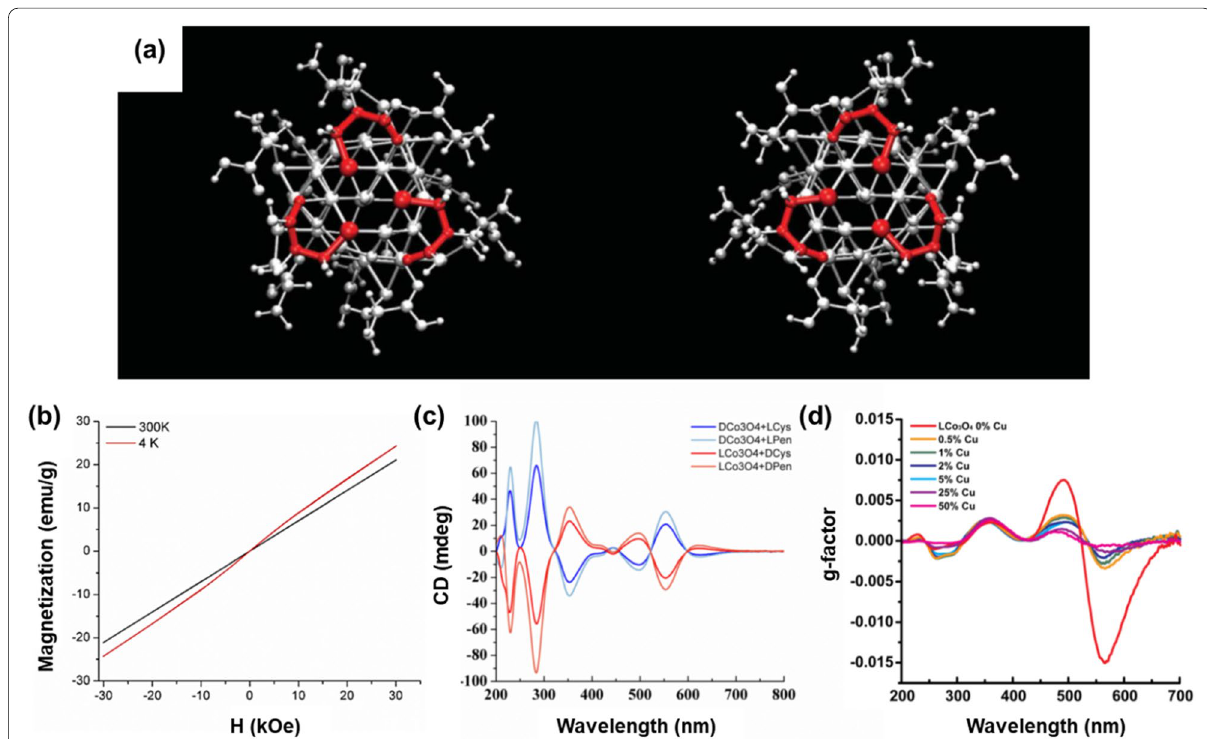
Fig. 7 a d -Cys and l -Cys Co 3 O 4 NPs. b Magnetic hysteresis loop at 300 K and 4 K. c CD spectra of d - and l -Cys Co 3 O 4 NPs with their ligand-exchanged counterparts using l - and d -penicillamine. d g- factor spectra of l -Cys Co 3 O 4 NPs with varying their Cu atomic concentration. Reproduced with permission from [9]. Copyright 2018